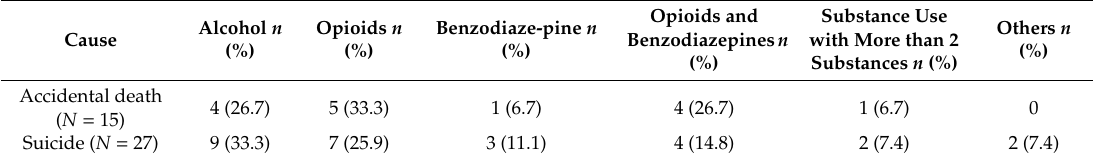
Table 5. Substance use and mode of